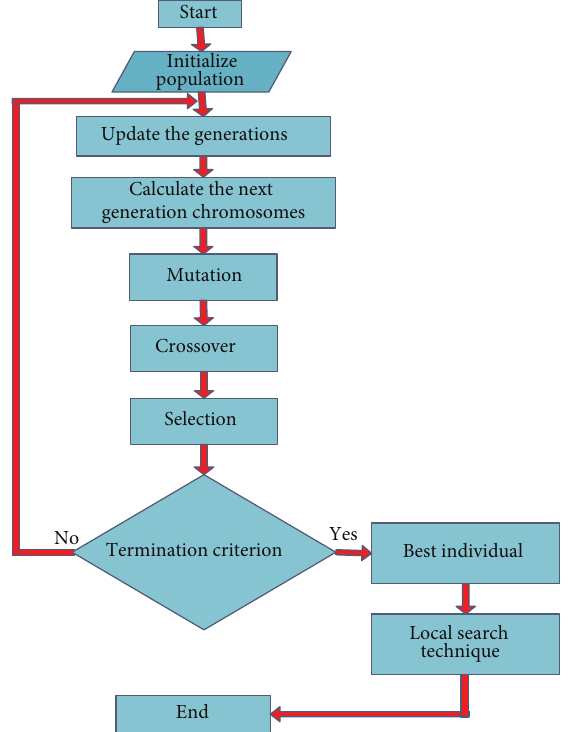
Figure 3: Generic flow diagram for hybrid